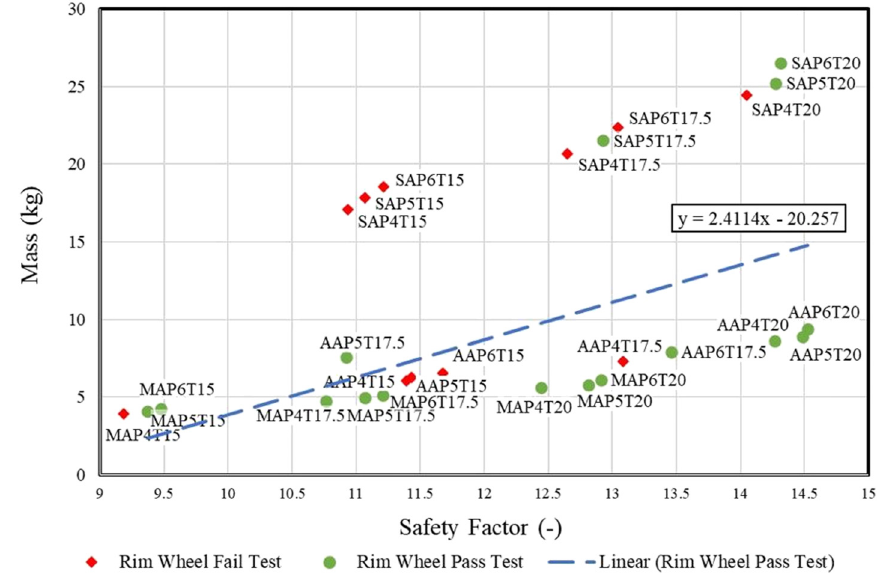
Figure 13: Response mass due to the safety